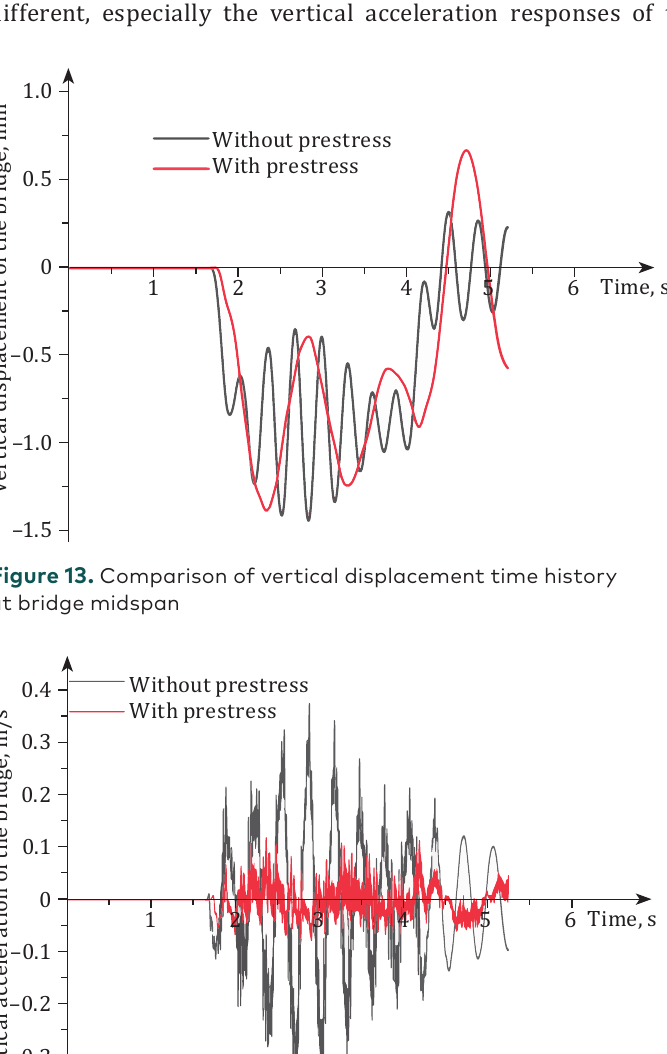
Figure 14. Comparison of vertical acceleration time history at bridge